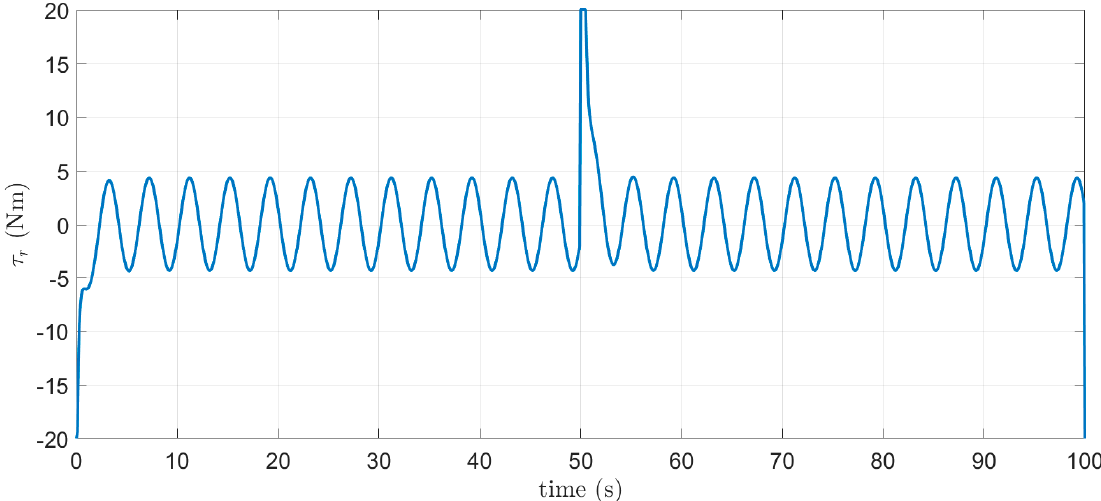
Figure 10. Simulation result of the control input of the direct adaptive control without robust action.